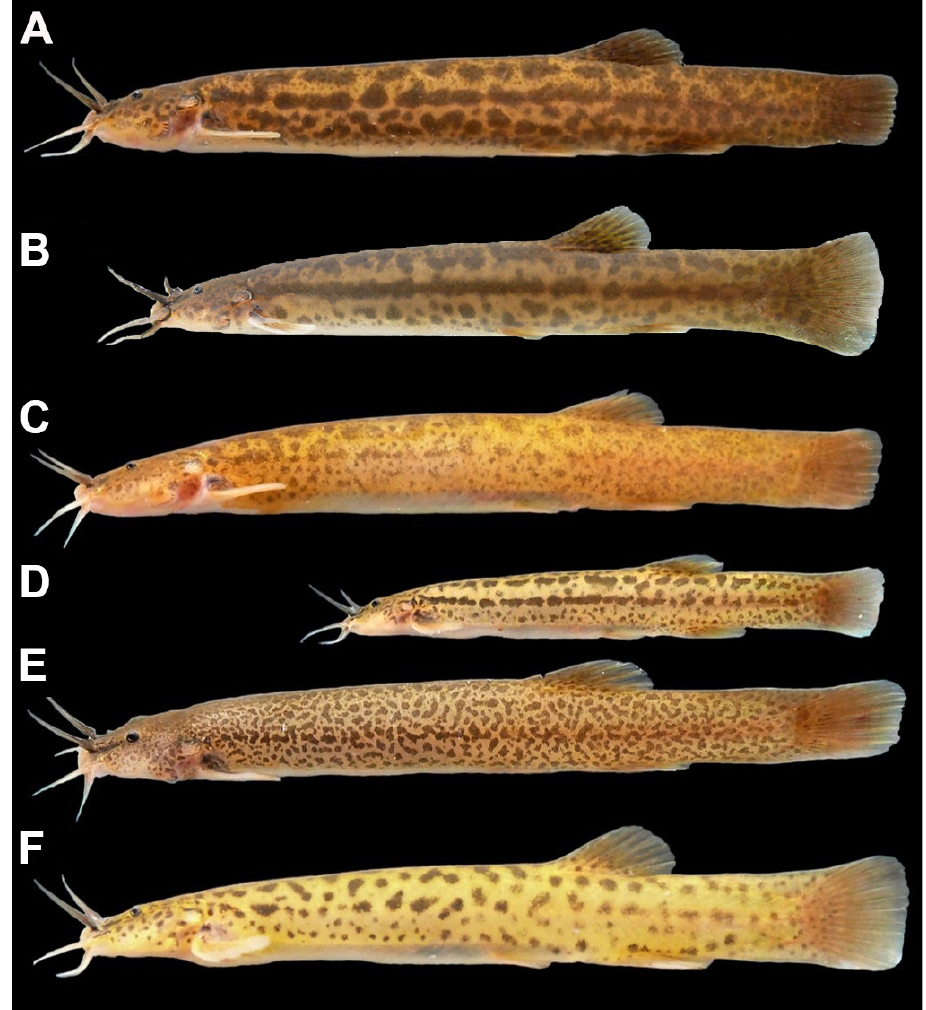
FIGURE 5 | Variation on the coloration in vivo and ontogenetic series of Cambeva botuvera from ( A, C–F ) Itajaí-Açu River, UFRGS 23182, 47.3 mm SL, 64.8 mm SL, 68.1 mm SL, 81.1 mm SL, 95.6 mm SL, respectively; and ( B ) from Itajaí-Mirim River, UFRGS 24558, 67.1 mm SL, showing the color pattern with two layers in the skin composed of large and small round black blotches in the inner and outer layer,